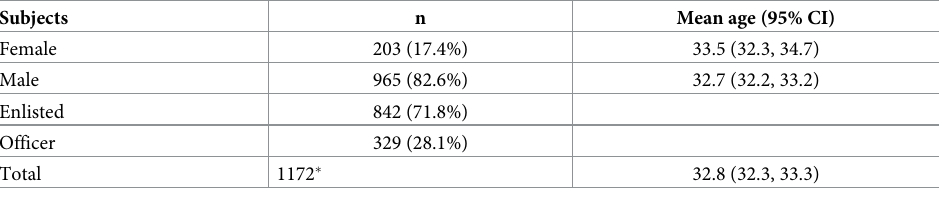
Table 1. Post deployment questionnaire